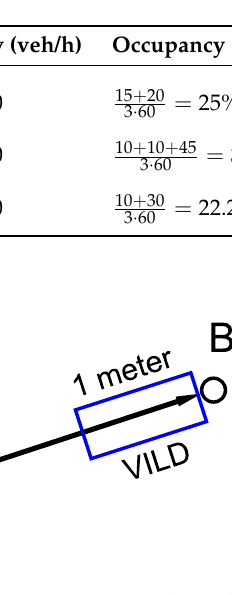
Figure 8. Virtual Inductive Loop Detector (VILD) on AB